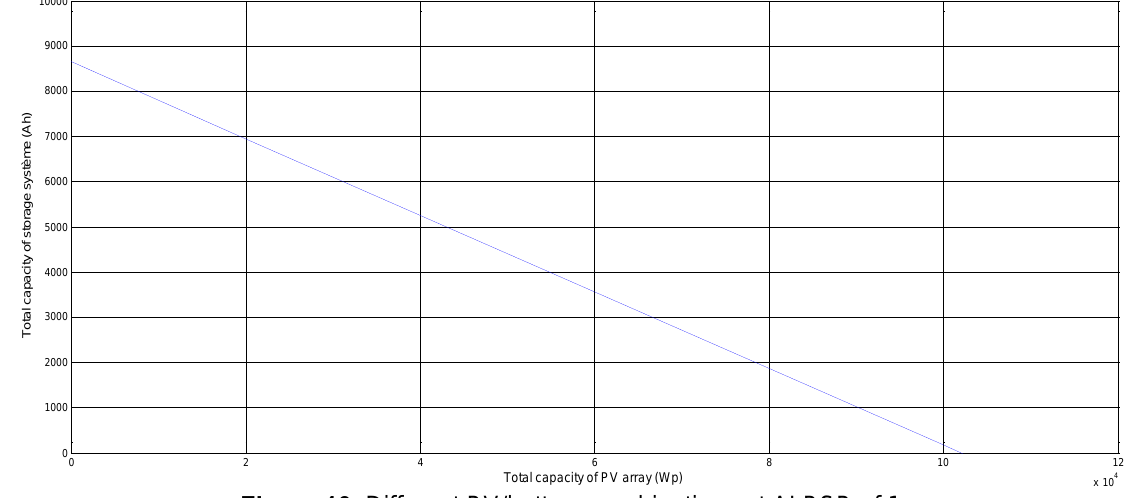
Figure 10 . Different PV/battery combinations at ALPSP of